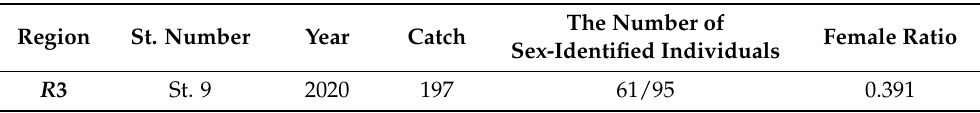
Table A3. The catch of chum salmon ( Oncorhynchus keta ) individuals and the number of females (Female ratio) in the R 3 region. St. Number